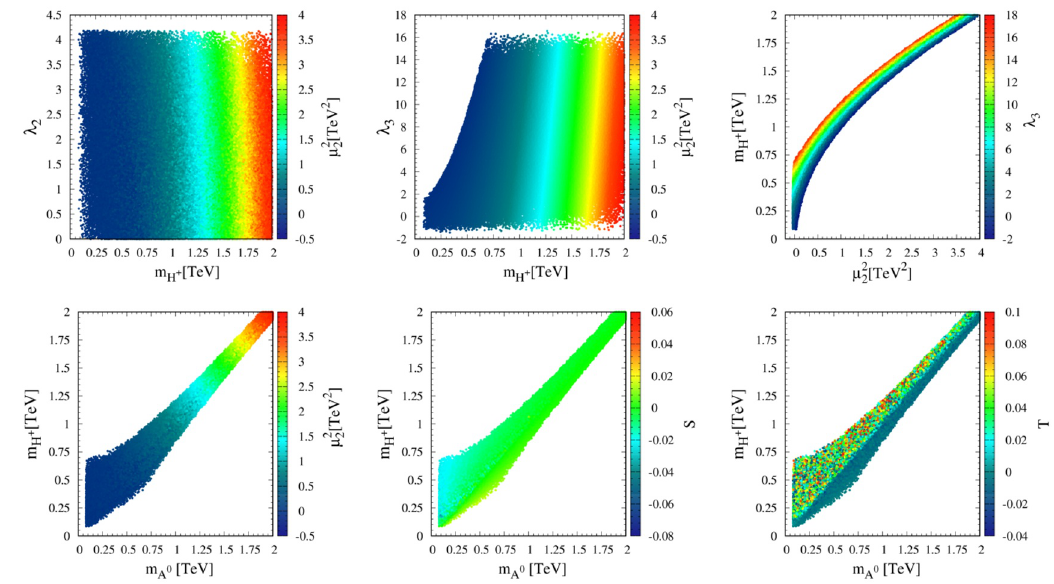
Figure 3 . Allowed parameter space in the non-degenerate IHDM spectra are shown, where various theoretical constraints and experimental bounds like the DS and EWPT are taken into account: a) ( λ ) plane with µ 2 colored on the vertical axis; b) ( λ 2 , m S 2 vertical axis; c) ( m ) plane with λ colored on the vertical axis; d, e, f) ( m 2 S , µ 3 2 , S and T parameters colored on the vertical axis, µ 2 2